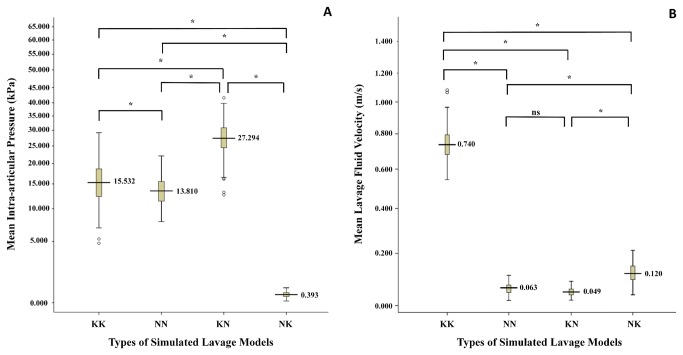
The intra-articular pressure (IAP) and lavage fluid velocity levels in four types of simulated models.(A) The IAP levels were significantly different between four groups (P<0.001). (B) The fluid velocity data in KK and NK groups were the two highest types (P<0.001), whereas no statistical difference was found between NN and KN groups (P=0.306). Standard deviation values are presented as error bars. (*P<0.001; ns, not significant.) .